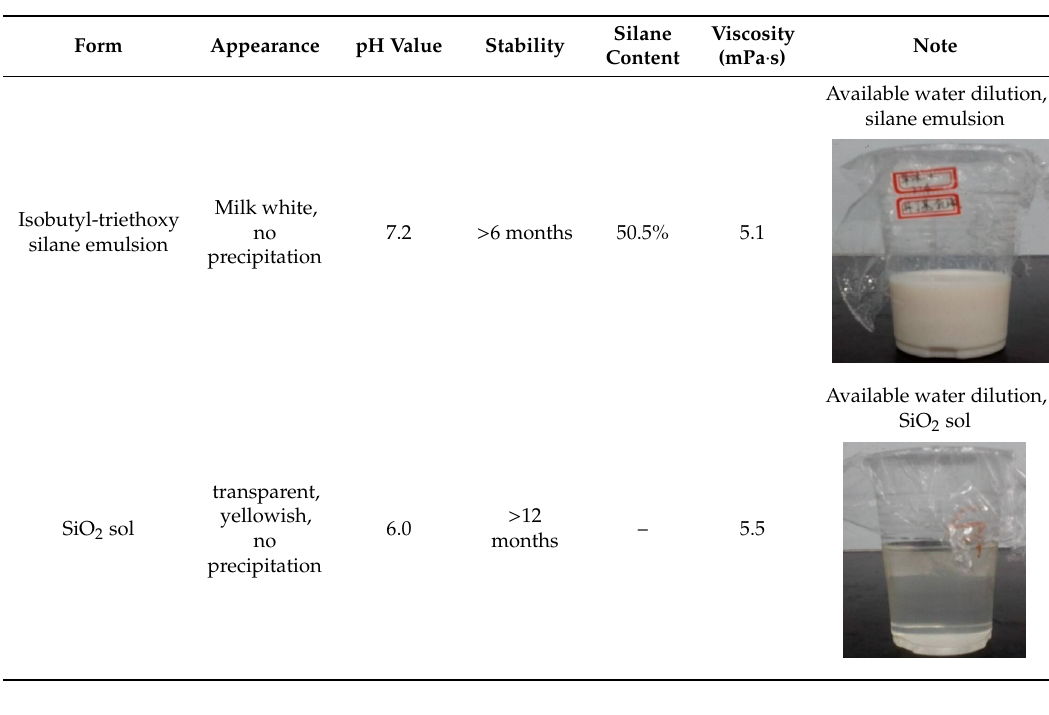
Table 2. Characteristic of silane emulsion and SiO 2 sol.